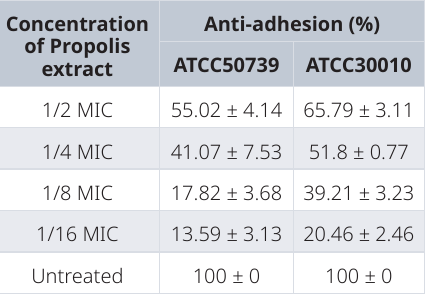
MIC: minimal inhibitory concentration. ATCC: American Type Culture Collection.